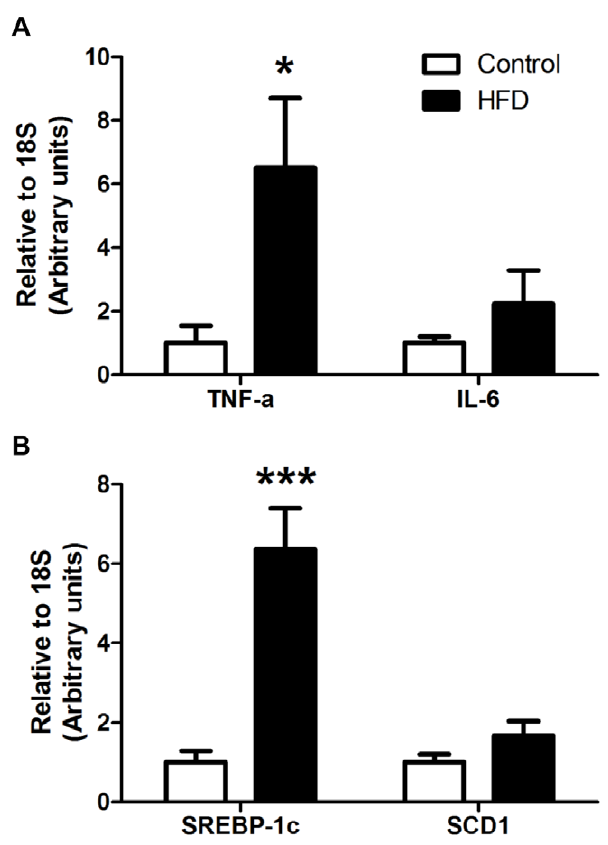
Figure 8. mRNA expression of genes involved in inflammation (A) and lipogenesis (B) in liver. mRNA levels of TNF- a , IL-6, SREBP-1c and SCD1 in control and high saturated fat diet (HFD) fed mice were measured using RT-qPCR. Gene expression was normalized to 18S. Open bars=control; Closed bars=HFD (n=14–16 per group). Data are shown as mean 6 SEM. *** P , 0.001 and * P , 0.05 compared to